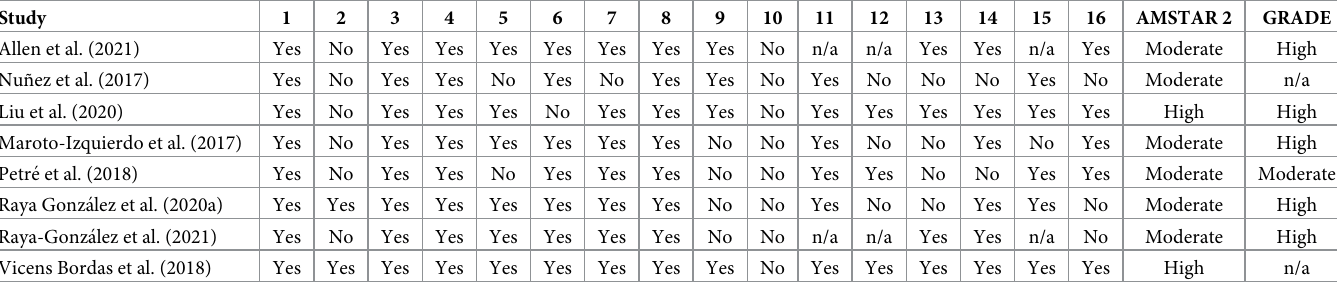
Table 2. Overall results of the AMSTAR 2 and GRADE recommendations for systematic reviews and